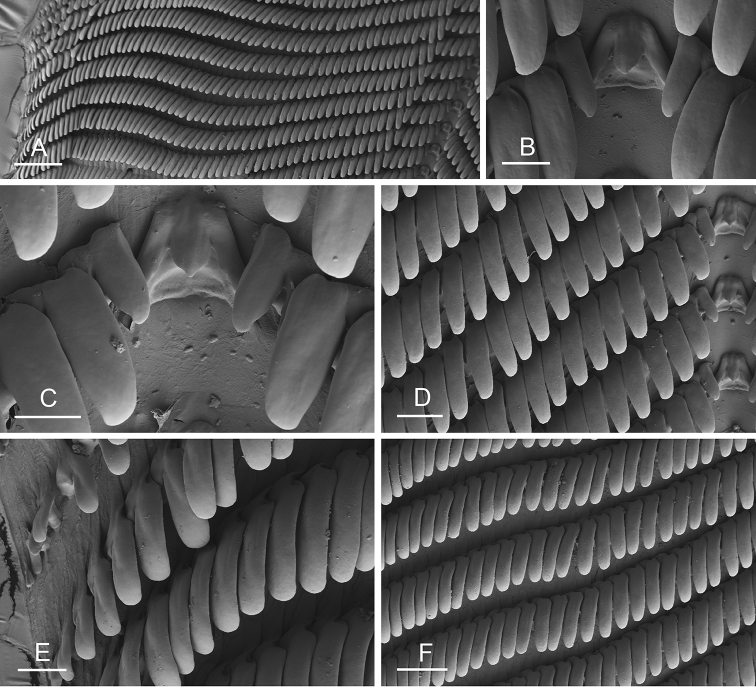
Radula, Peronia
verruculata (unit #1), Indonesia A, B Seram [2870] (UMIZ 00169) C–F Lombok [2987] (UMIZ 00168) A left half rows of teeth B rachidian and innermost lateral teeth C rachidian and innermost lateral teeth D rachidian and lateral teeth E outermost lateral teeth F lateral teeth. Scale bars: 200 μm (A), 30 μm (B, C), 60 μm (D), 40 μm (E), 100 μm (F).